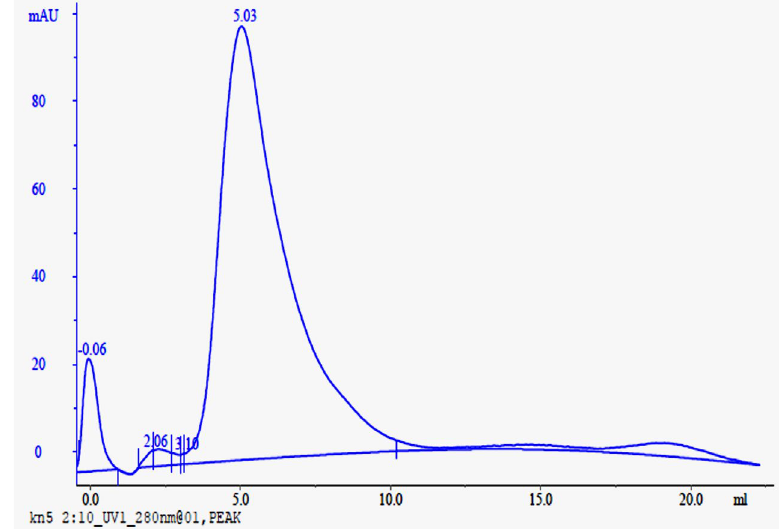
Fig. 3. Purification of laccase from Streptomyces syiceus strain KN3 by